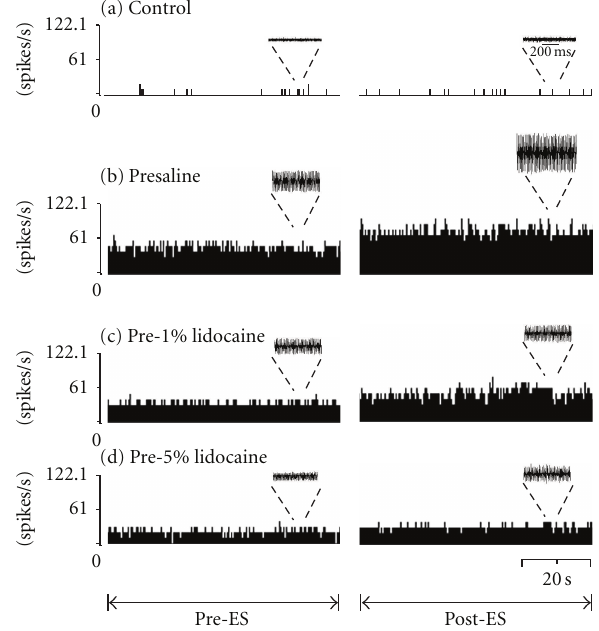
Figure 2: Electrophysiological recording of chronic constricted median nerves at pre- and postelectrical stimulation, (pre-ES and post-ES) stages. Data were collected and transformed into frequency histogram for control (a), presaline (b), pre-1% lido (c), and pre-5% lido (d) groups. Original recordings presented above the histogram, respectively. Note that the rates of discharges were significantly reduced with increasing concentrations of lidocaine Figure 1: E ff ects of pre-emptive treatment of saline or various concentrations of lidocaine on paw withdrawal threshold in CCI rats. Pre-treatment of lidocaine increased paw withdrawal threshold and attenuated the TH in CCI rats. (cid:0) P 0 . 05 compared to the (cid:0) presaline group.